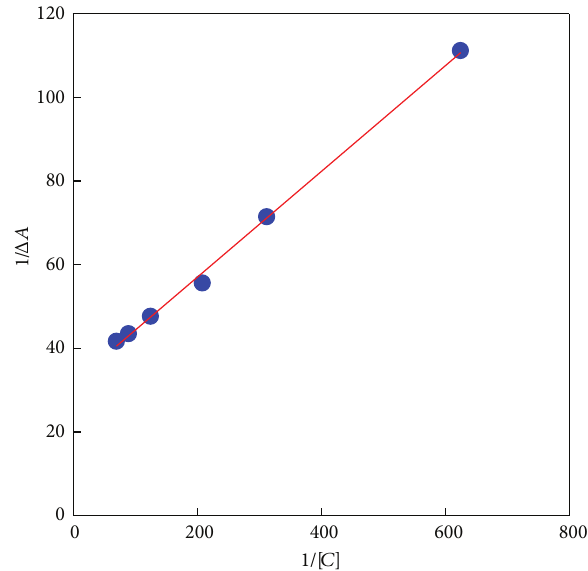
Figure 2: Benesi-Hildebrand plot for the complexation of benzoyl metronidazole with 𝛽